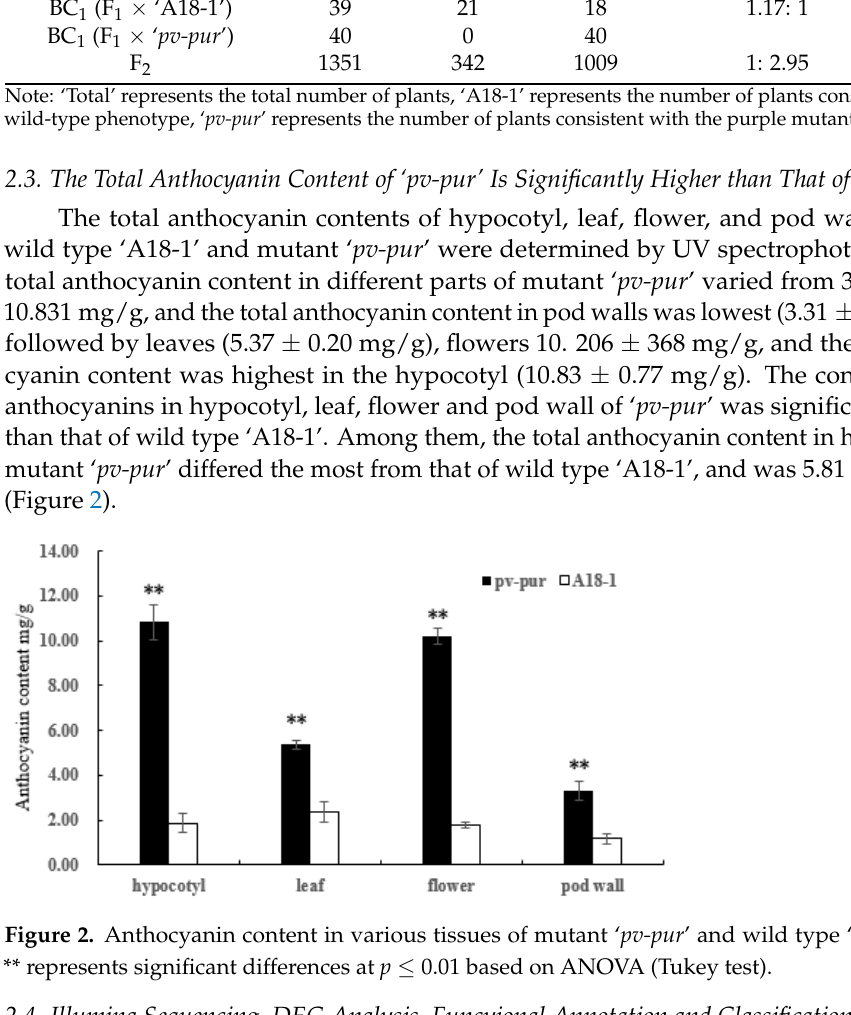
Table 1. Genetic analysis of purple mutant pv-pur in Phaseolus vulgaris .